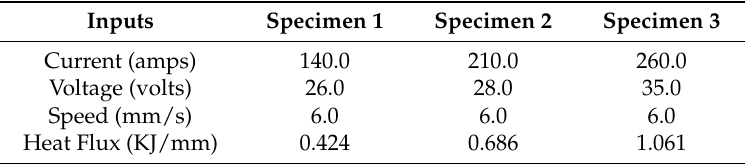
Table 1. Values of current, speed, voltage and power to manufacture the three welded specimens.